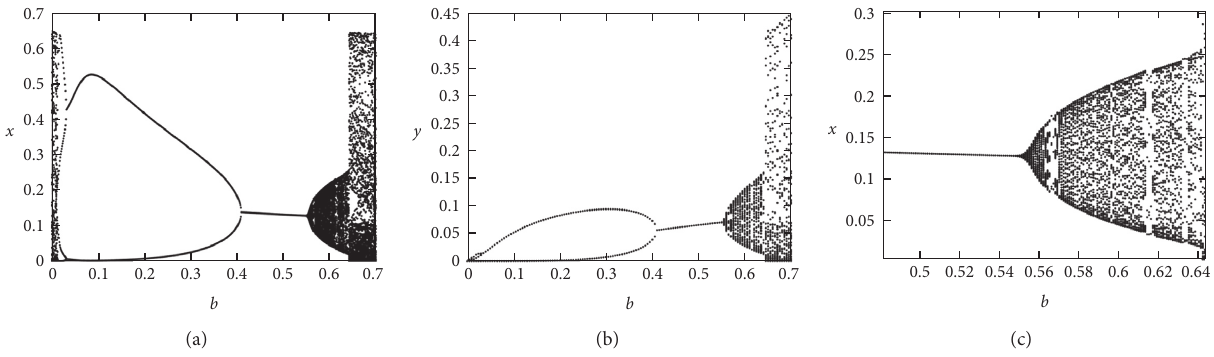
Figure 4: Bifurcation diagrams of equation (3) ( c � 0 . 8 , β � 22, a � 38, and 0 < b <